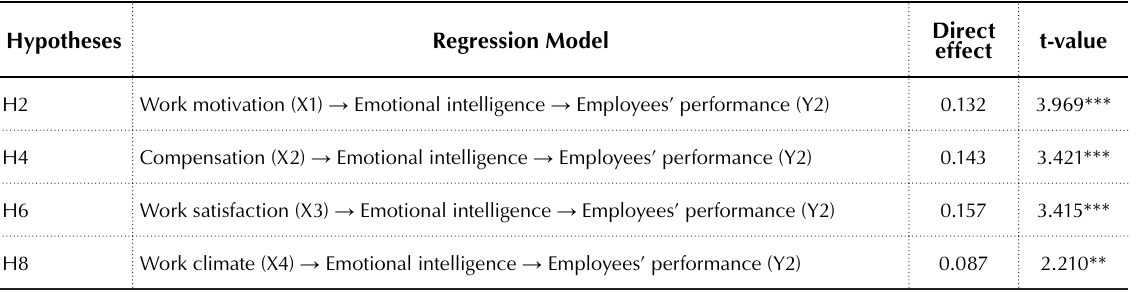
Table 2. Hypotheses testing of indirect effect Hypotheses